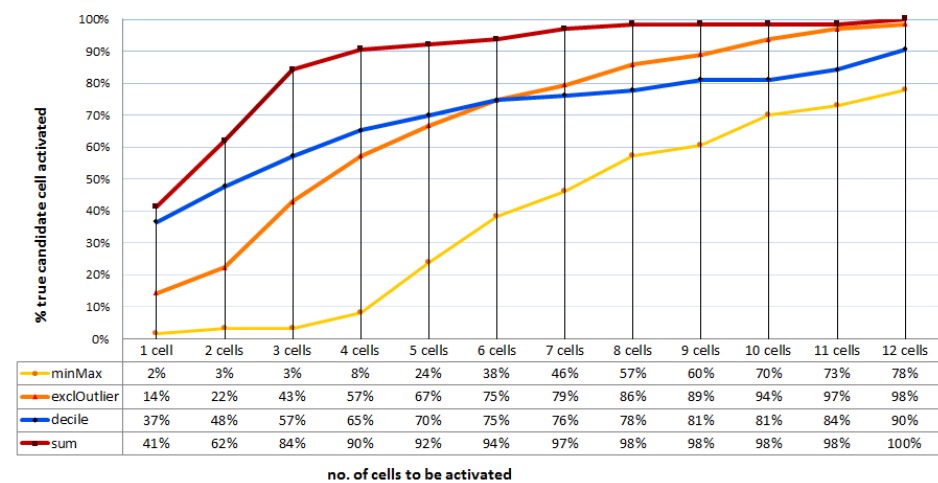
Figure 12. Relation of successful candidate cell activation to the number of cells to be